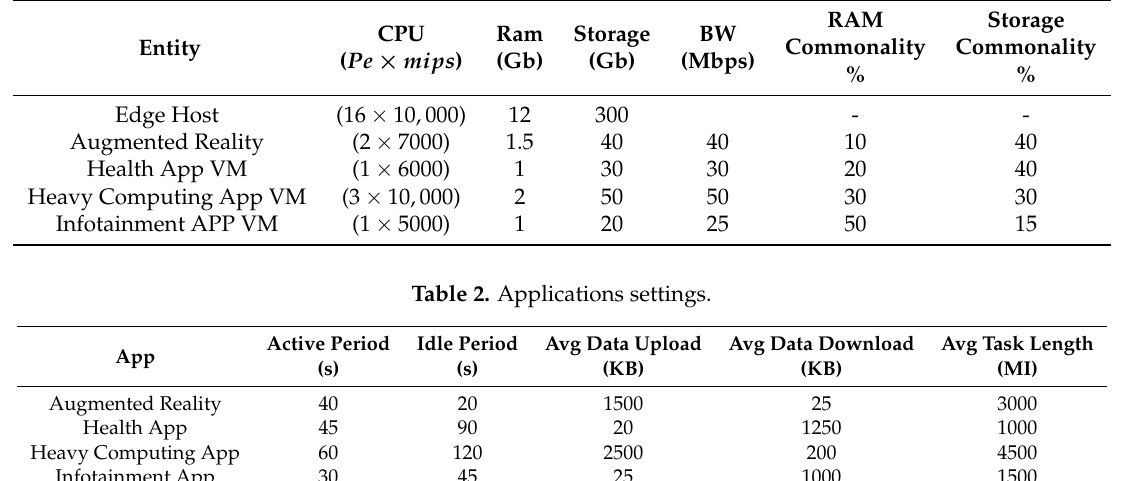
Table 1. Hosts and VMs settings.